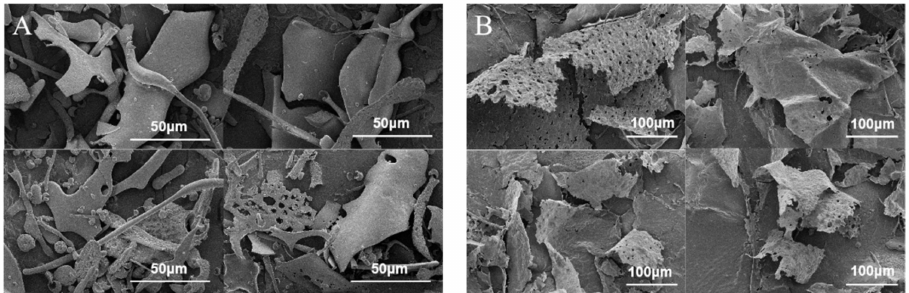
Figure 4. Scanning electron micrograph images of Artp1 and Artp2. ( A ) Artp1, × 3000 and × 2000, 50 µ m; ( B ) Artp2, × 1000, 100 µ